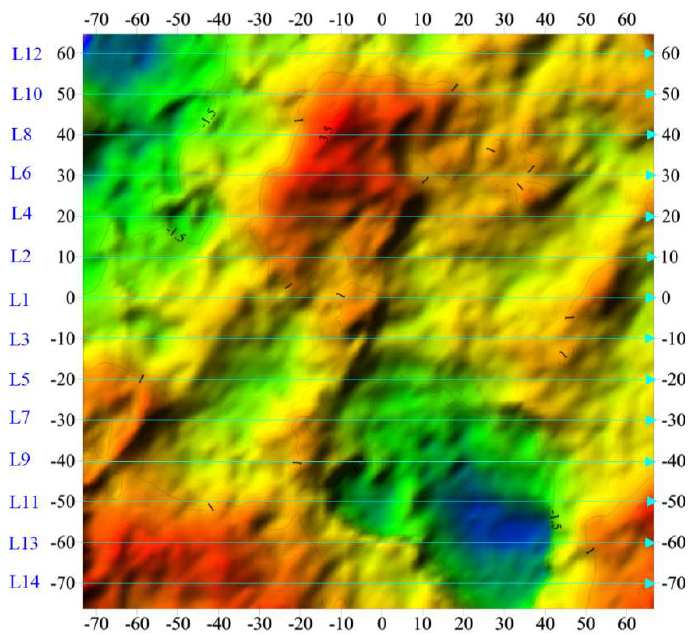
Figure 4. Fourteen parallel profile lines along the shear direction.